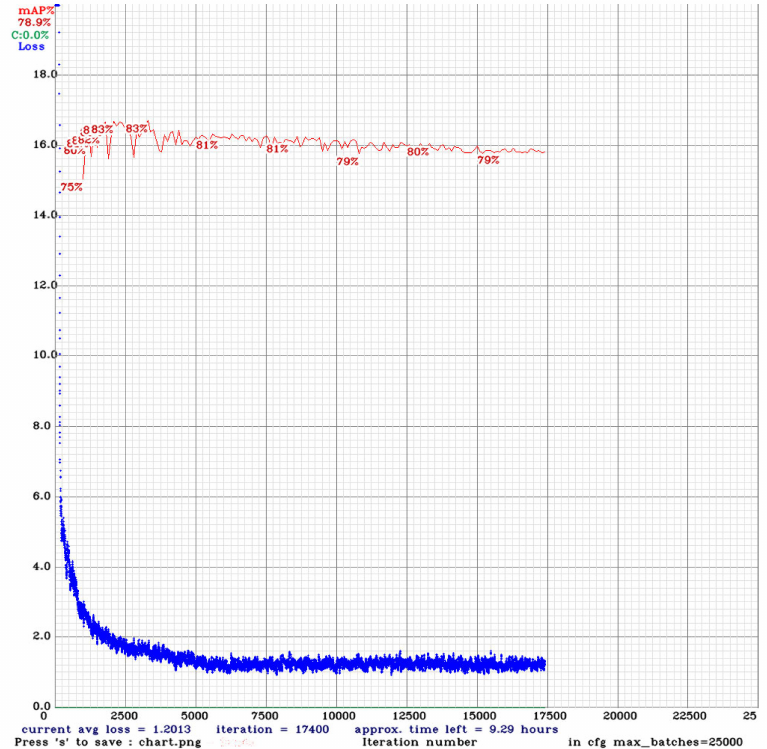
Figure 16. The performance of YOLOv4 on the TACO and simple aerial trash